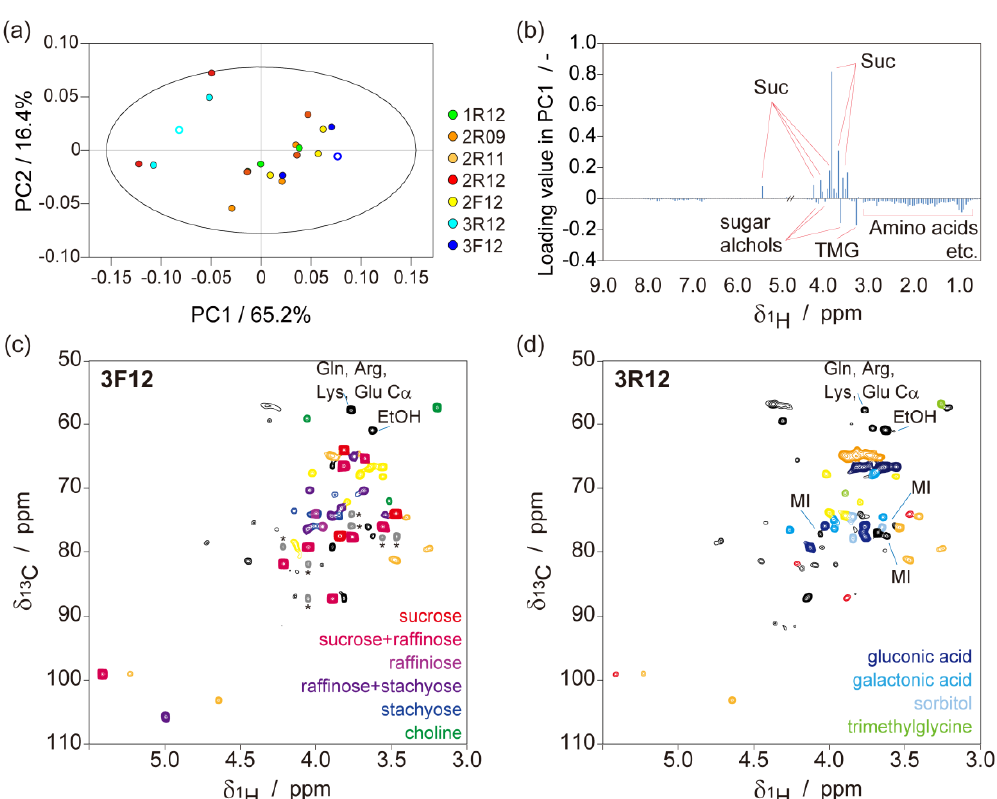
Figure 2. NMR analysis for water-soluble metabolites in seeds. ( a ) A score plot of PCA, in which bucket integrated (0.05 ppm/bucket) 1 H-1D spectra were used. An ellipse in score plot was represented the Hotelling’s T2 95% confidence. The open circle plot indicates samples taken using the 1 H- 13 C HSQC spectra of 3F12 ( c ) and 3R12 ( d ); ( b ) A loading plot of the PC1. The indicated molecules were assigned in the 1 H- 13 C HSQC spectra. The 1 H- 13 C HSQC spectra of 3F12 ( c ) and 3R12 ( d ). Colored signals are referenced in the lower right of the spectra. Signals indicated by asterisks in ( c ) were long-range correlations in sucrose via n J CC ( n > 1). Suc; sucrose, MI; myo-inositol, TMG;